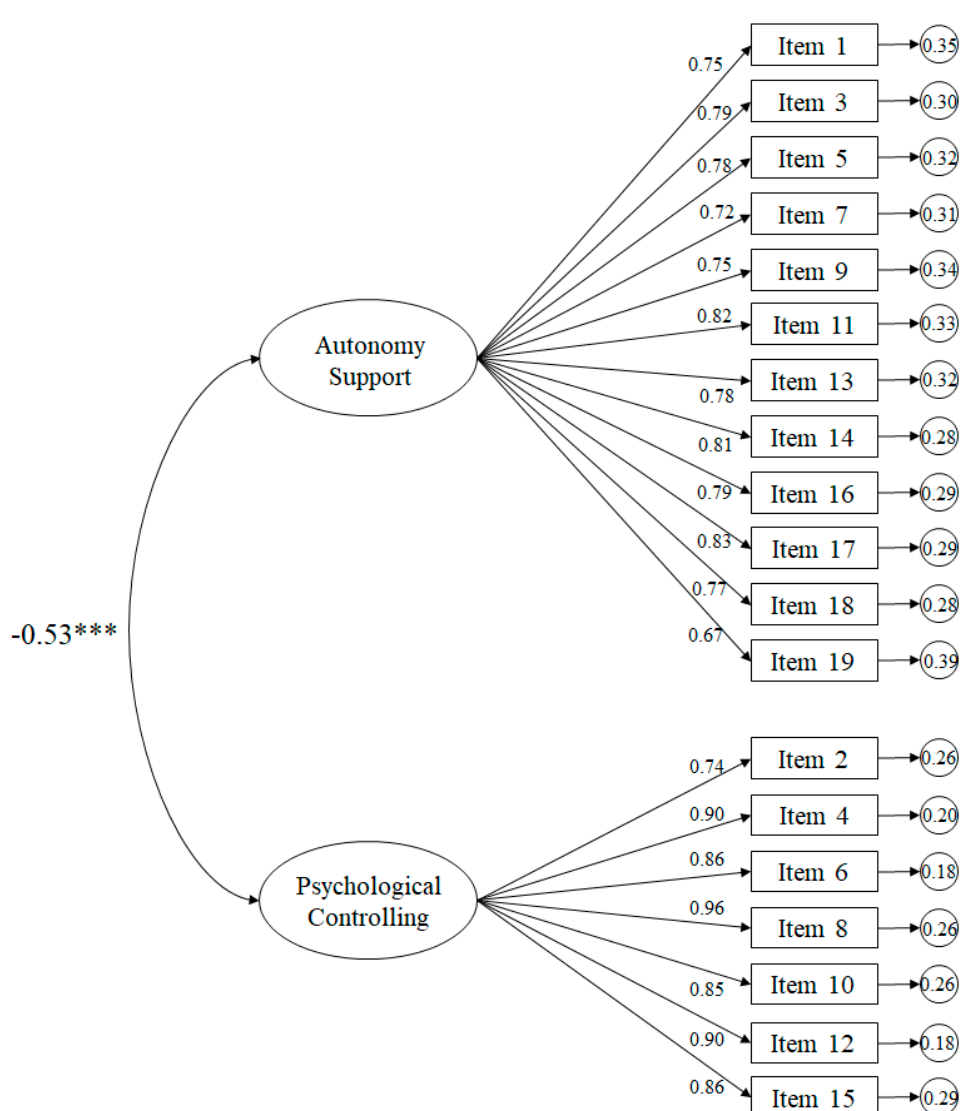
Figure 3. Confirmatory factor analysis of the SPSEC-F. The ellipses represent the factors and the rectangles represent the various items. Residual variances are shown in the small circles.